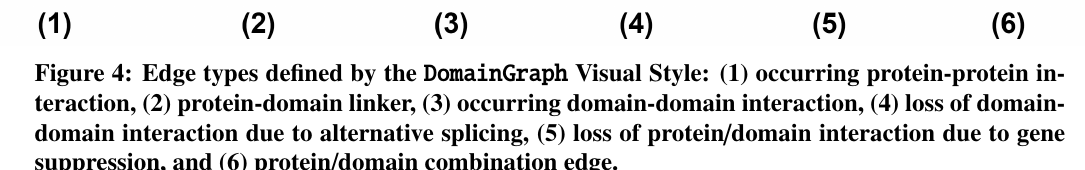
Figure 4: Edge types defined by the DomainGraph Visual Style: (1) occurring protein-protein in- teraction, (2) protein-domain linker, (3) occurring domain-domain interaction, (4) loss of domain- domain interaction due to alternative splicing, (5) loss of protein / domain interaction due to gene suppression, and (6) protein / domain combination